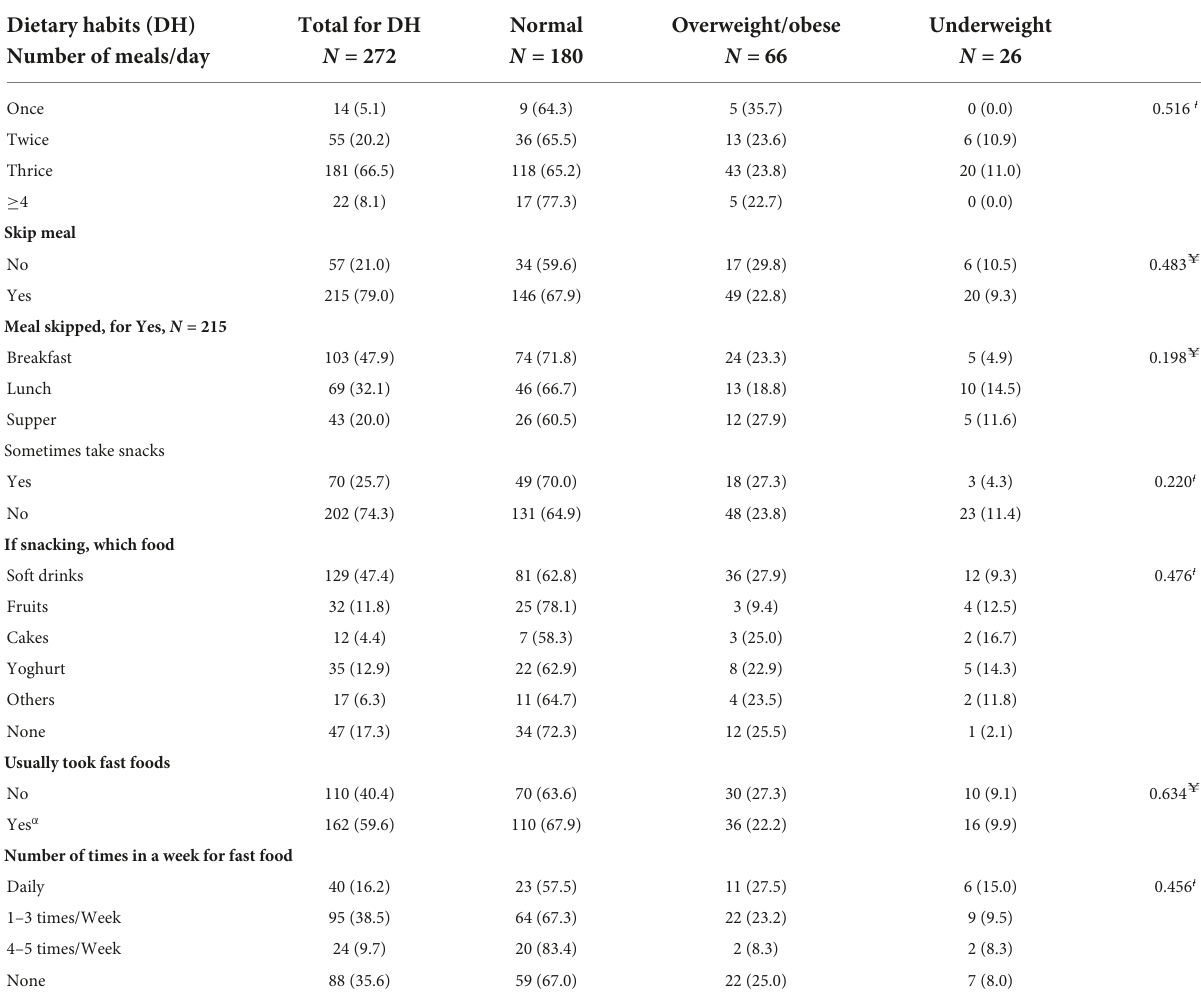
Table 5 indicates Pearson correlation between calories, macronutrient intakes and anthropometric indices, when age and gender were adjusted. Independent of age and gender, caloric intake ( r = 0.196, p = 0.001), dietary carbohydrate TABLE 3 Dietary habits and body mass index